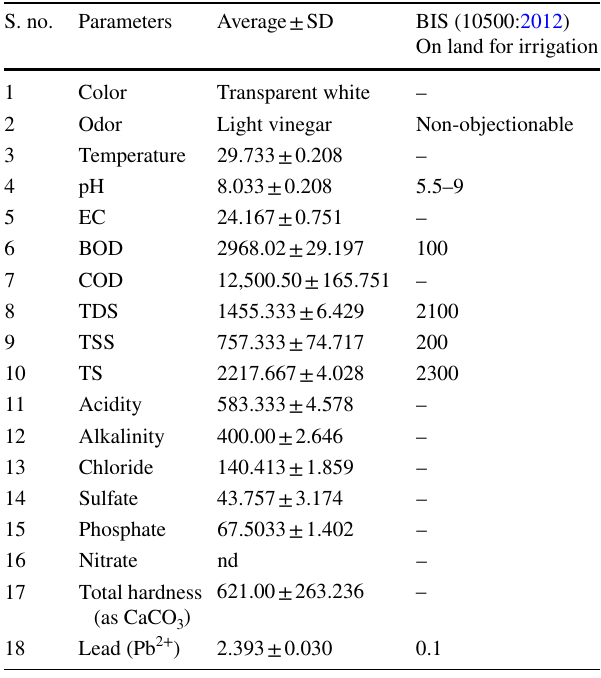
Table 1 Physicochemical properties of battery manufacturing